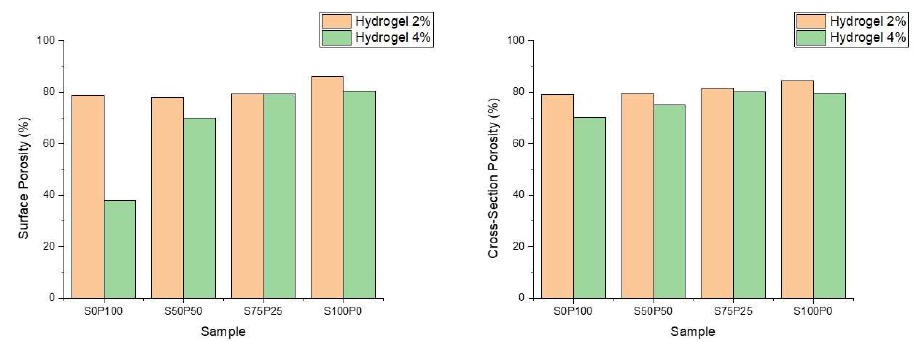
Figure 5. The porosity of the sericin/PVA hydrogels resulting from SEM image analysis on the sample surface and cross-section. Hydrogels 2% and 4% denote the concentration of sericin and PVA.